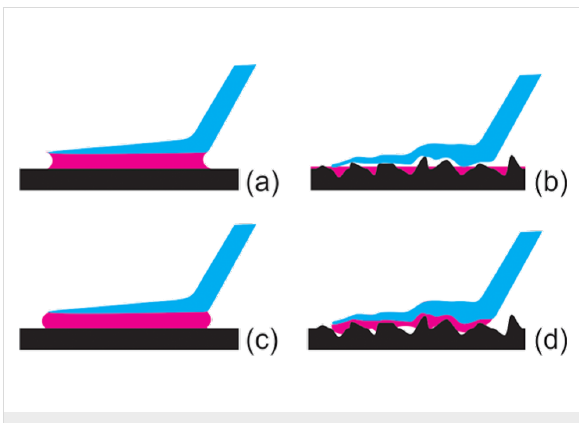
Figure 4: Hypothetical wetting behavior of the pad fluid (purple) in the contact region between the tenent setal tip (blue) and different sample surfaces (black): (a,c) flat surfaces, (b,d) textured surfaces; (a,b) fluids that readily wet the surfaces, (c,d) and fluids that poorly wet the sur-